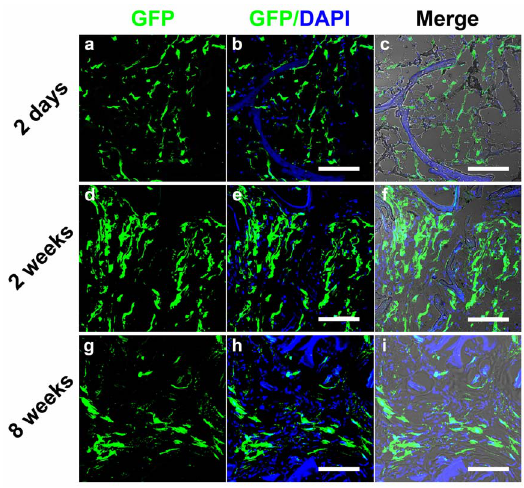
Figure 4. Sequential observation of GFP labelled cells in the silk scaffolds in rat cranial bone defects for 8 weeks. ’Merge’ represented the merged images of GFP/DAPI image and transmitted light image. Scale bars are 50 m m.